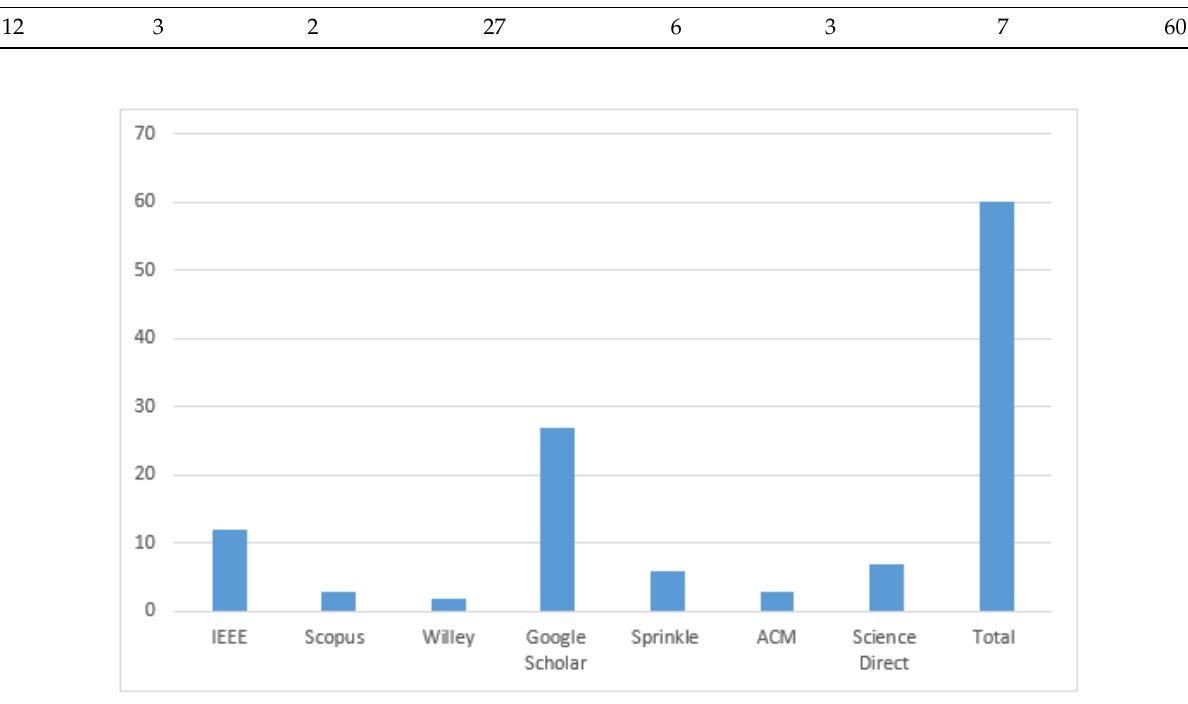
Figure 3. Year-wise selection of papers.